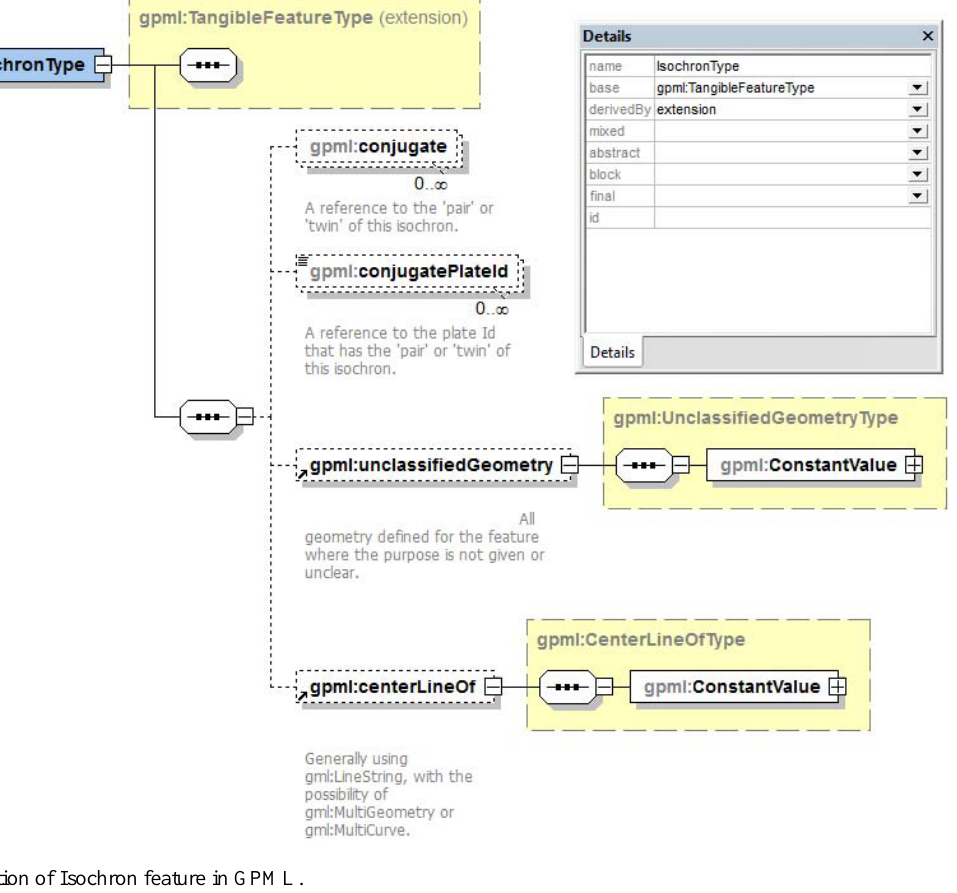
Fig. 12. The definition of Isochron feature in GPML.